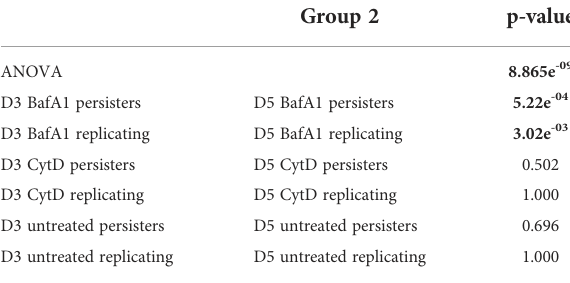
TABLE 5 Metabolic activity between groups at day 3 and day 5. TABLE 6 Metabolic activity between days 3 and 5.Group